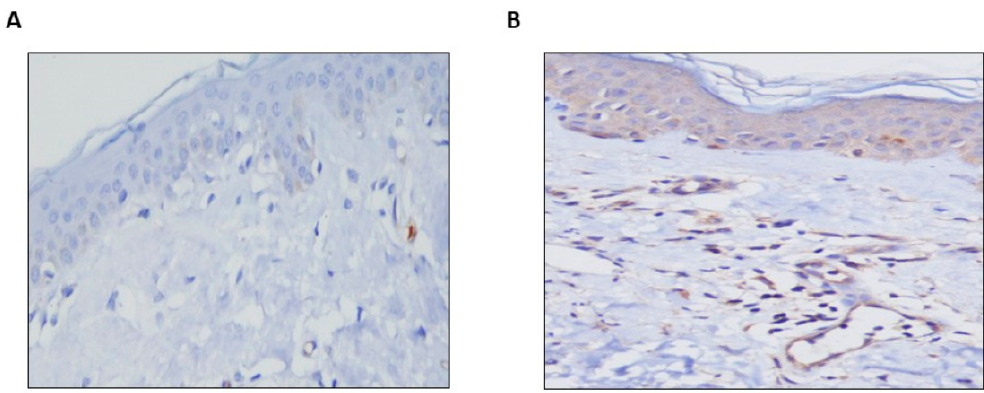
Figure 1. Semaphorin5A expression is increased in the lesional skin of patients with CSU. Almost no Sema5A expression is seen in the skin of healthy control subjects ( A ) as compared to strong expression in the skin of CSU patients ( B ). The pictures are 20 × magnification. Both CD4+ T cells and mast cells (CD117+) showed the expression of Sema5A in the skin of patients with CSU and healthy control subjects. The skin of patients with CSU had 5-fold higher numbers of Sema5A-expressing CD4+ T cells and 3-fold higher numbers of Sema5A-expressing mast cells, as compared to health control skin ( p < 0.05; Figures 2 and 3). Figure 2. CD4+T cells in the lesional skin of patients with CSU express Semaphorin5A. Sema5A is expressed by CD4+ T cells ( B , white arrows)) in the skin of CSU patients compared to healthy con- trols ( A ). ( C ) shows the results of quantitative analysis of the double-staining of Sema5A/CD4+T as evaluated by IMARIS software (as detailed in the “Methods” section). The pictures are 40× magni- fication. **** statistically significance.